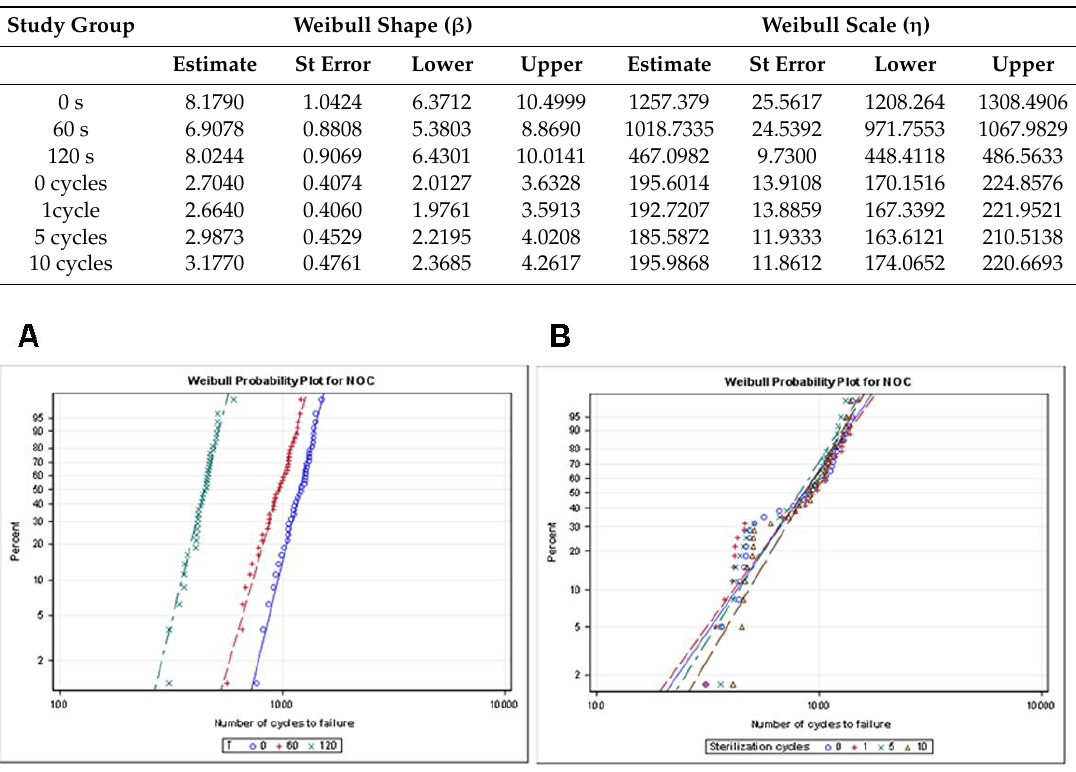
Figure 6. ( A ) Weibull probability plot of the number of cycles to failure for the time of use and ( B ) sterilization cycles study groups.